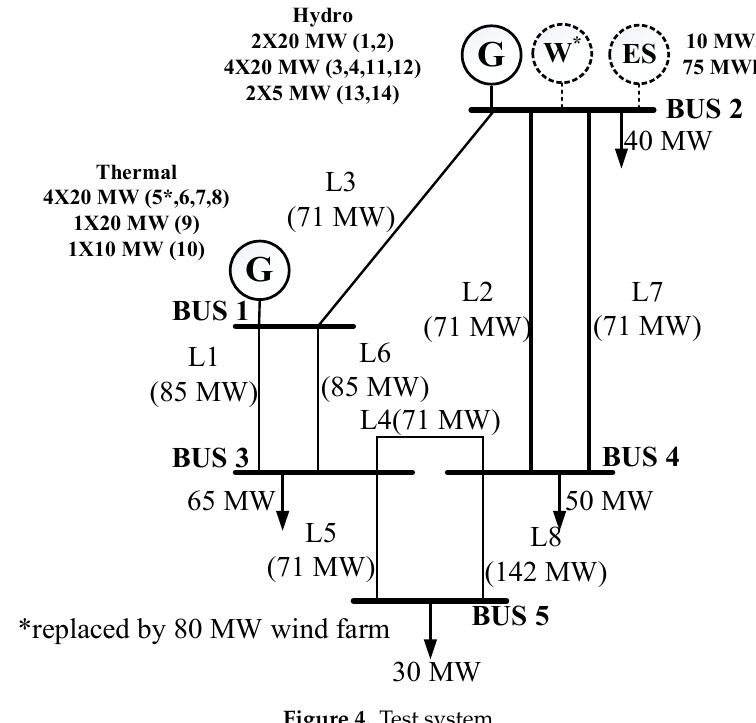
Figure 4. Test system. Table 2. Generation and transmission line